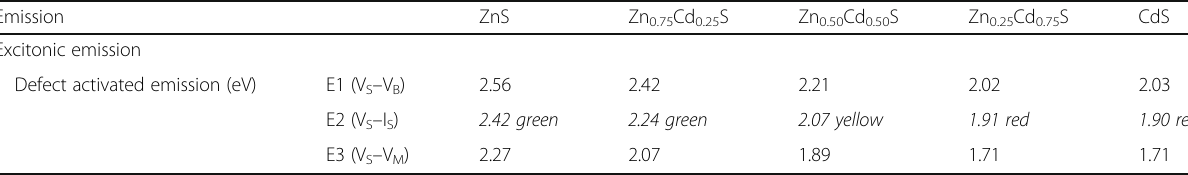
Table 1 Summary of types and energies of Zn x Cd 1 − x S QD emissions